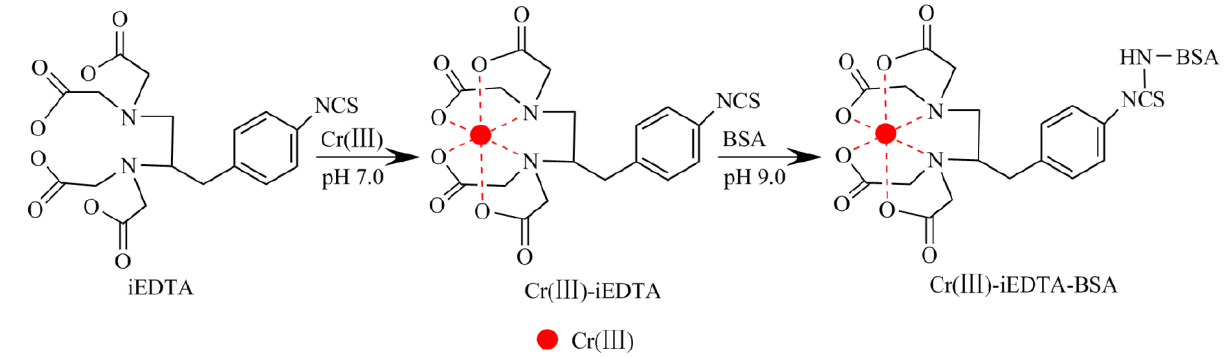
Figure 10. Synthesis scheme of the Cr( Ш ) － iEDTA － BSA via the isothiocyanate method.